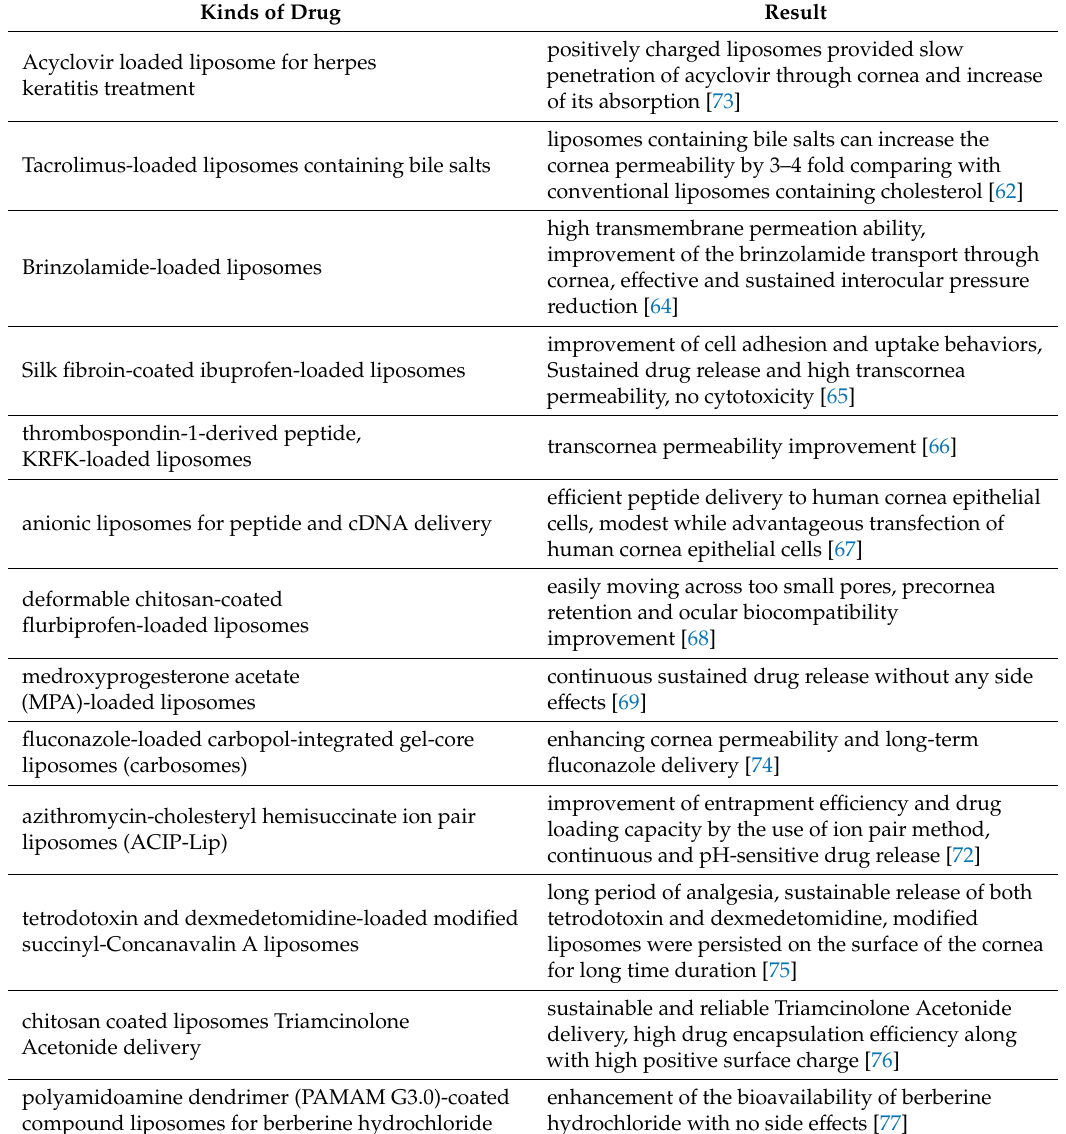
Table 1. Advancement in liposomal for cornea drug